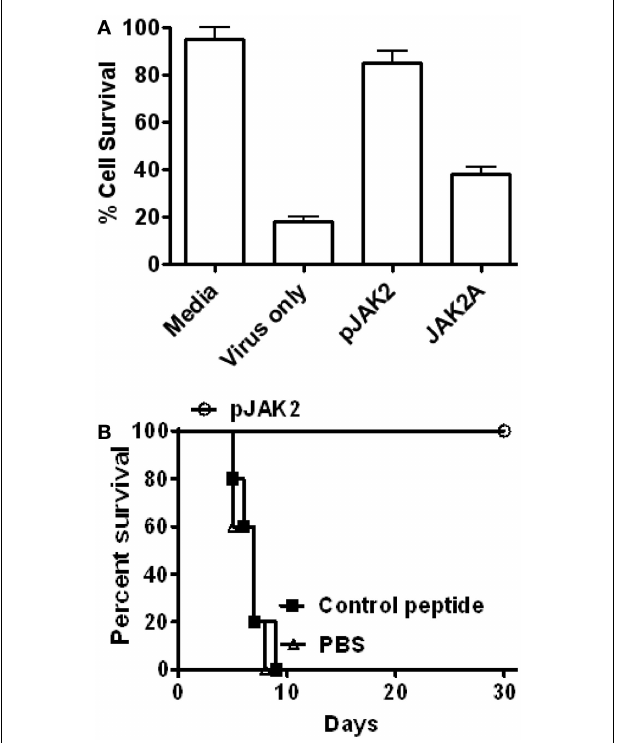
FIGURE 1 | SOCS antagonist protects mice against influenza A virus infection . (A) MDCK cells were infected with influenza A virus in the presence of SOCS1 antagonist or its control peptide. After 24h of infection, cells were stained with crystal violet and the cell survival was measured. The significance of differences was p = 0.001, p = 0.006, and p = 0.001 for virus only, pJAK2 and control peptide, respectively, versus media only. (B) Mice (C57BL/6, n = 5) were infected intranasally with 10 (cid:2) LD 50 of influenza A PR/8 (H1N1) virus. Starting with day 1, PBS, or 200 μ g each of SOCS antagonist, or the alanine-substituted antagonist control peptide were injected i.p. daily for 1week. Palmitate was attached to all peptides for cell penetration. Survival of mice was followed. p Value of < 0.01 was observed for the SOCS antagonist versus the control peptide. For more details on the peptides, see Section “Materials and